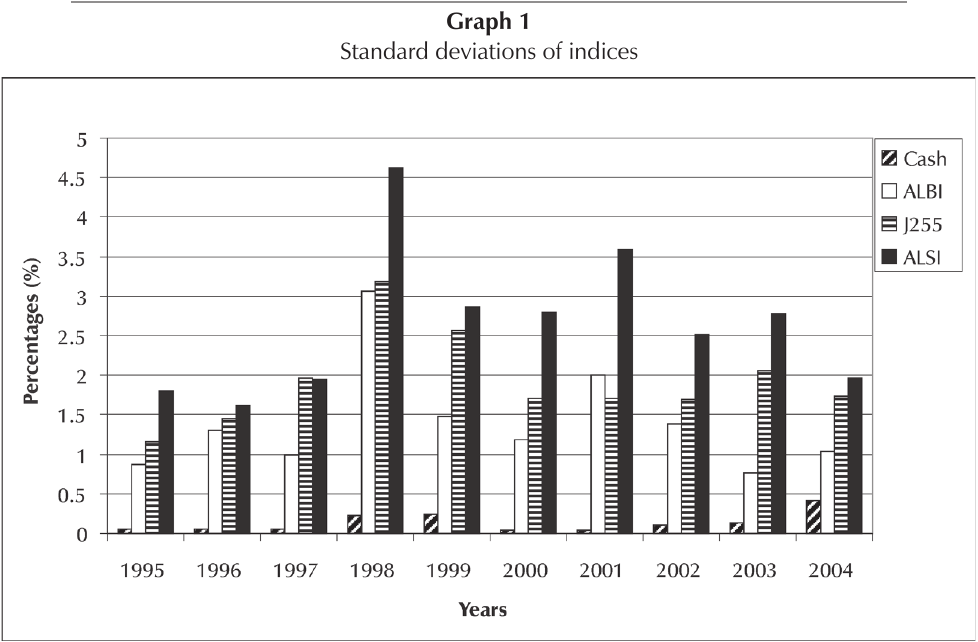
covariances between indices over the study period.